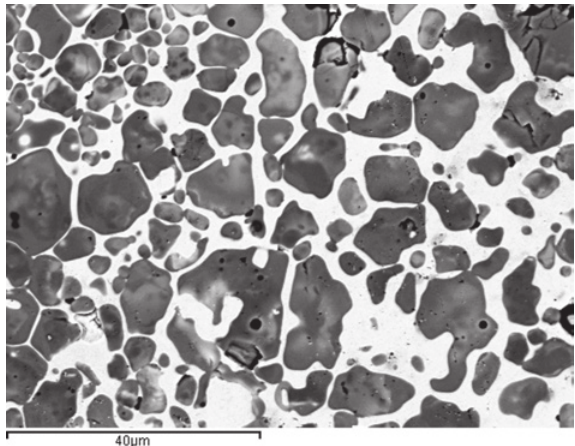
Fig. 11: SEM-BSE image of the penetration zone in experiment 6 (Fe-TiCMo